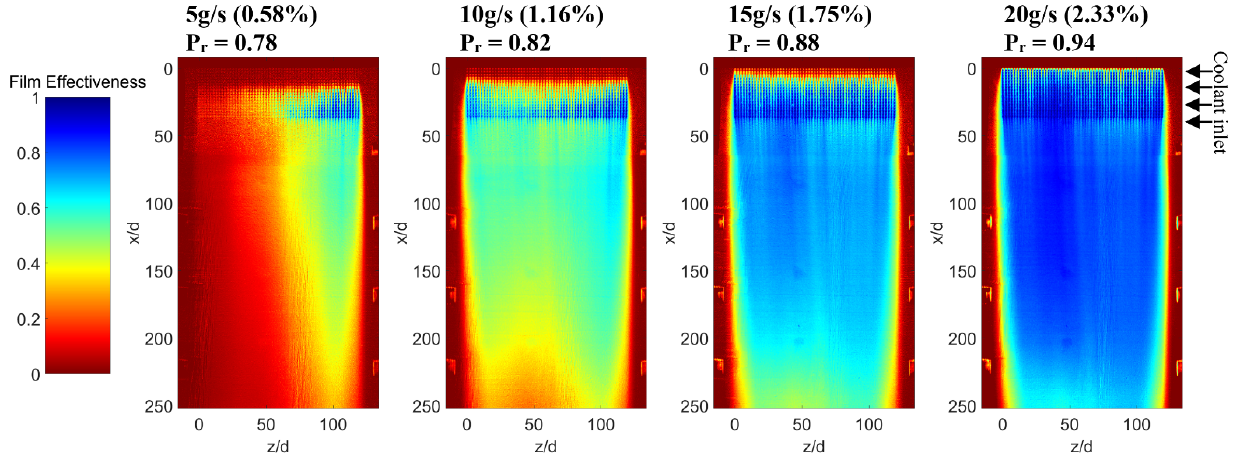
Figure 2. Film effectiveness of Panel 1 at different coolant mass flow rates (mass fraction).